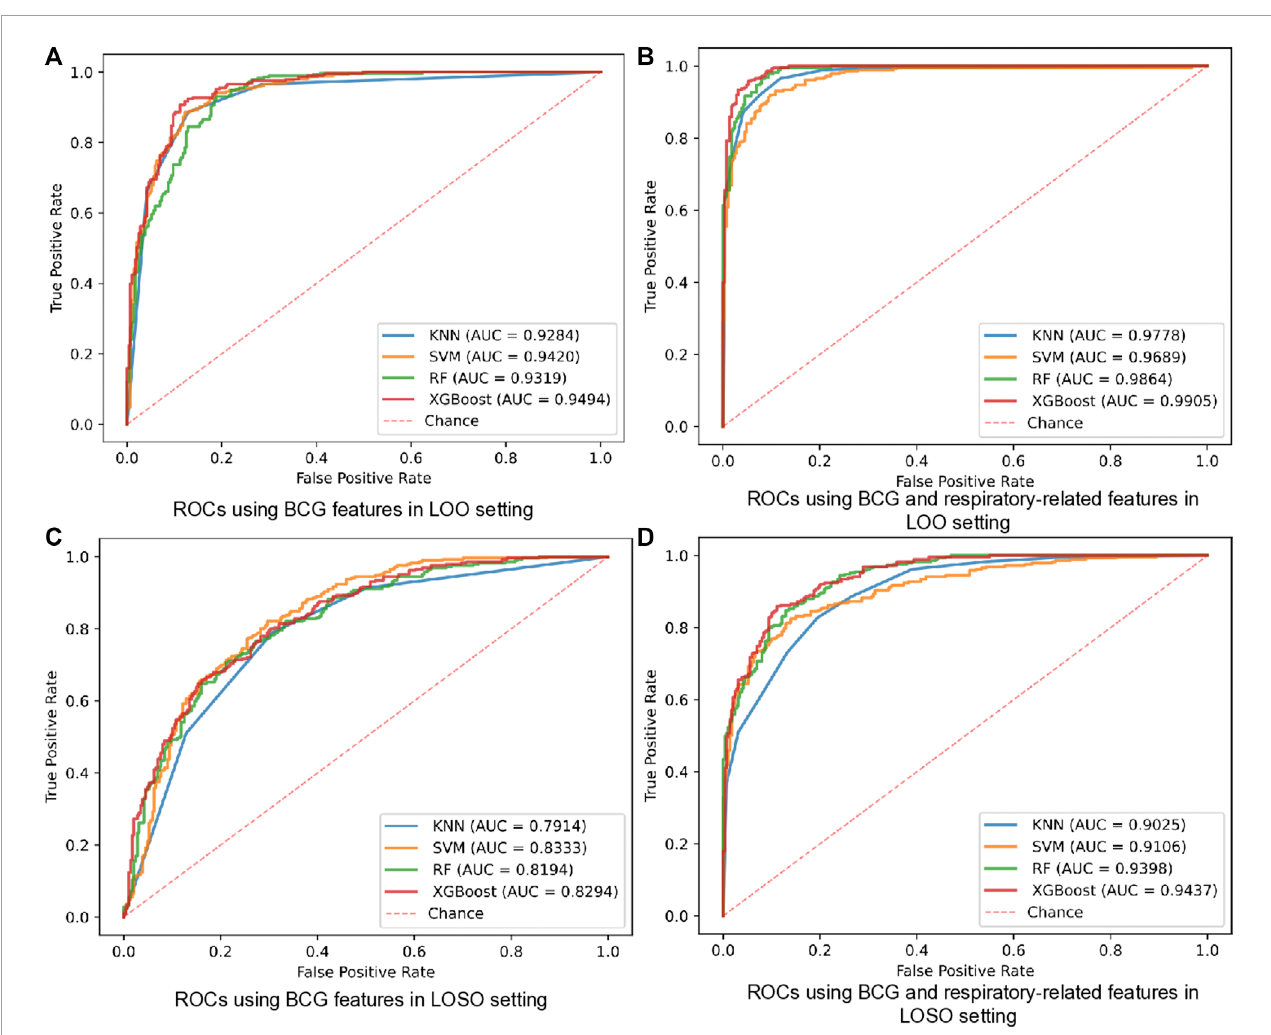
FIGURE 4 ROCs of HF diagnostics based on BCG and respiratory-related features using 4 classifiers in all datasets. (A) ROCs using BCG features in LOO setting. (B) ROCs using BCG and respiratory-related features in LOO setting. (C) ROCs using BCG features in LOSO setting. (D) ROCs using BCG and respiratory-related features in LOSO